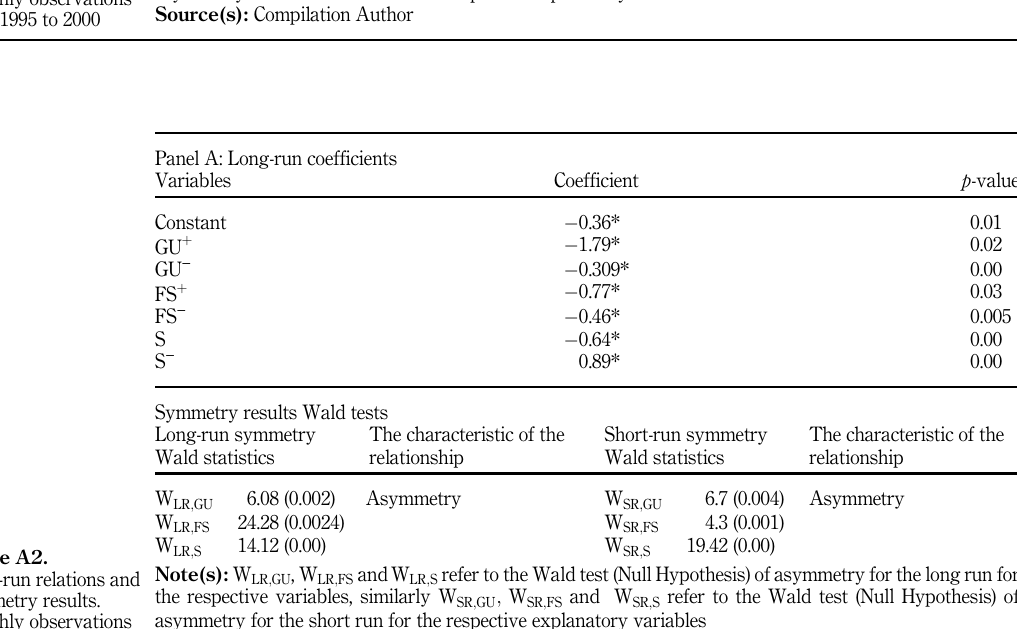
Table A1. Long-run relations and symmetry results. Monthly observations from 1995 to 2000